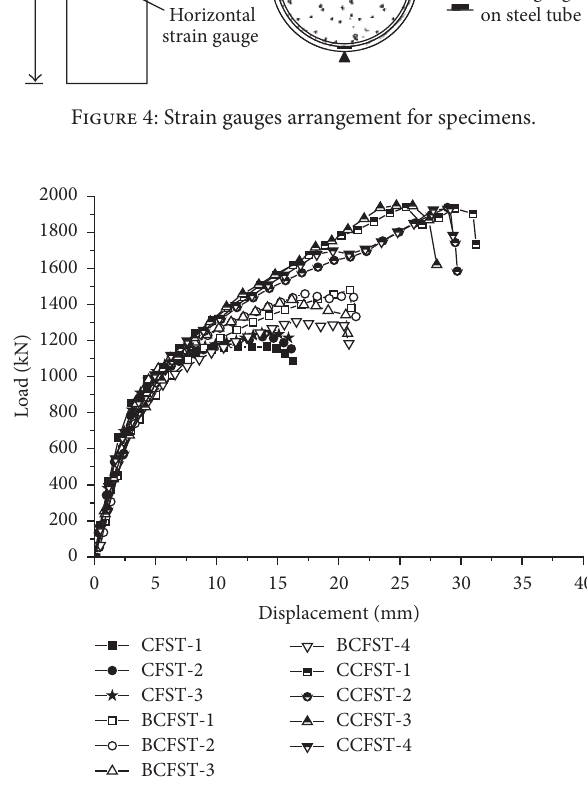
Figure 5: Load-displacement curves.